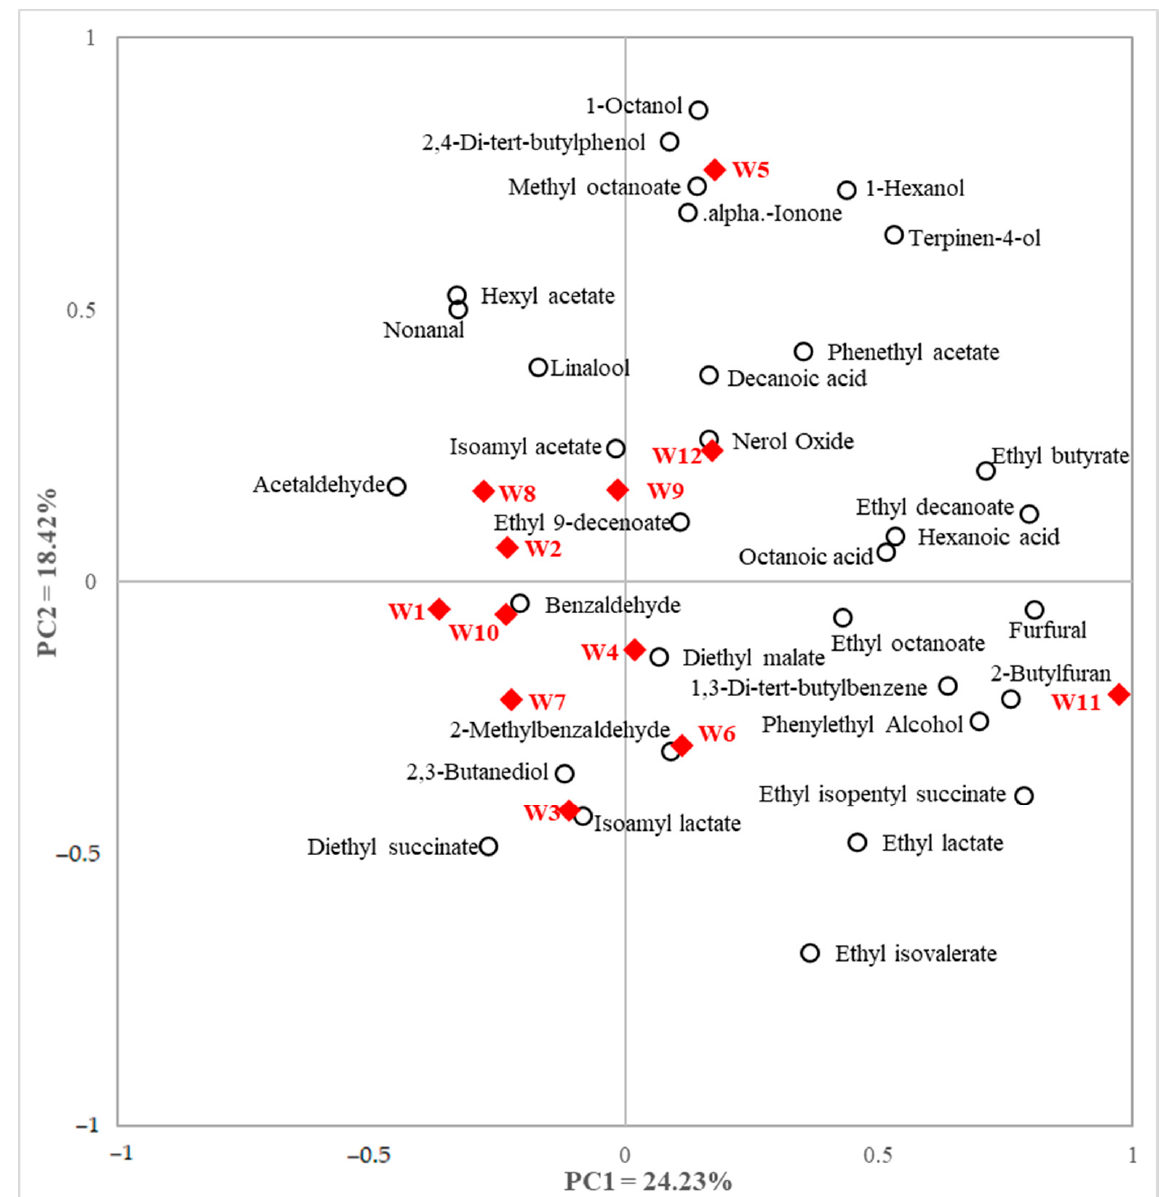
Figure 2. Principal component analysis (PCA) biplot of white wine samples and volatile compounds; solid diamonds indicate white wine samples and empty circles indicate volatile compounds.